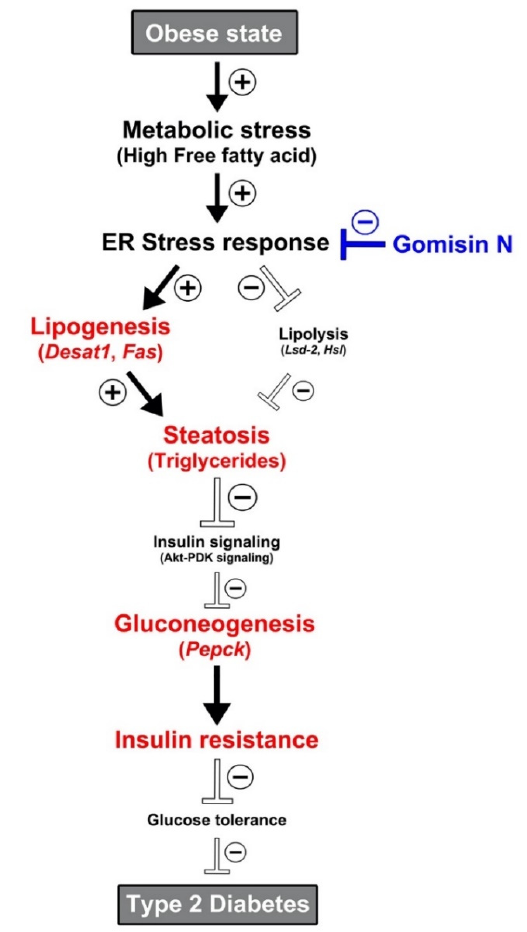
Figure 5. A schematic diagram describing altered metabolic processes in the obese state, along with potential regulation of ER stress response by gomisin N. The ⊕ and Θ symbols represent the activation and inhibition of subsequent metabolic pathways, respectively.